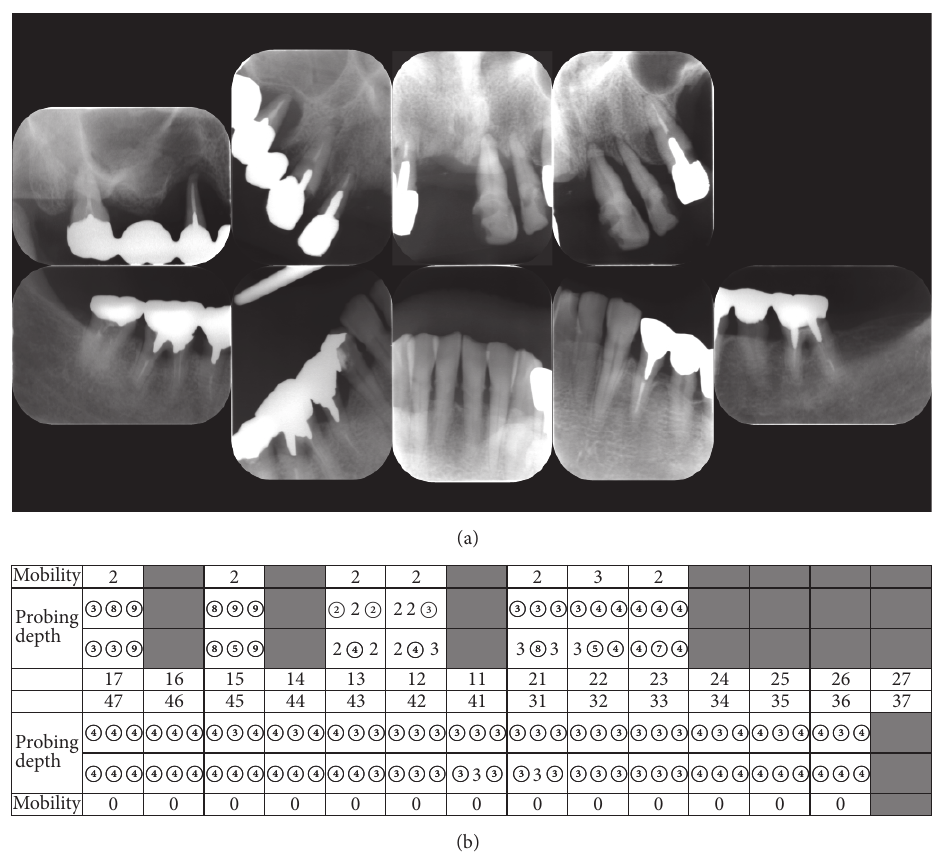
Figure 1: (a) X-ray images and (b) periodontal chart at initial dental visit. Circle on number indicates bleeding on probing.